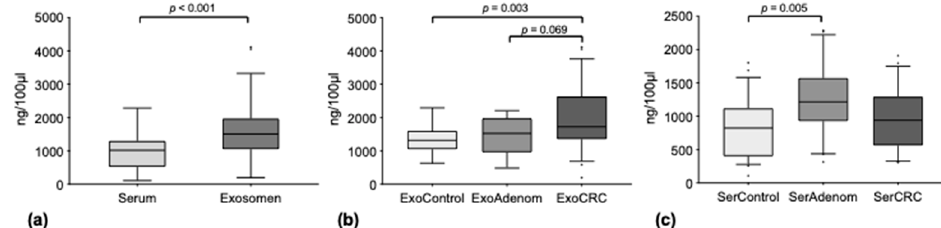
Figure 1. Median total miRNA concentrations ( a ) free circulating in serum and in the exosomal compartment; ( b ) in the exosomal compartment of healthy controls (ExoControl), adenoma patients (ExoAdenoma) and carcinoma patients (ExoCRC); ( c ) free circulating in serum of healthy controls (SerControl), adenoma patients (SerAdenoma) and carcinoma patients (SerCRC). Outliers are plotted as individual dots.